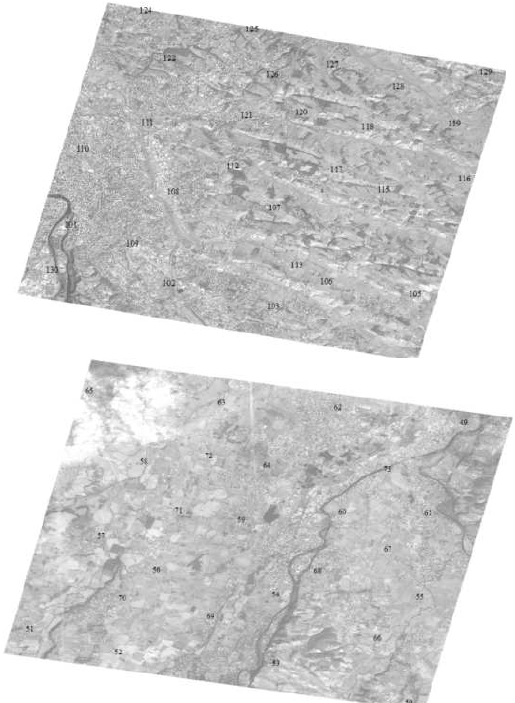
Figure 2. Toulouse images and GCPs distribution. Table 3. Results for different sets of parameters using the first